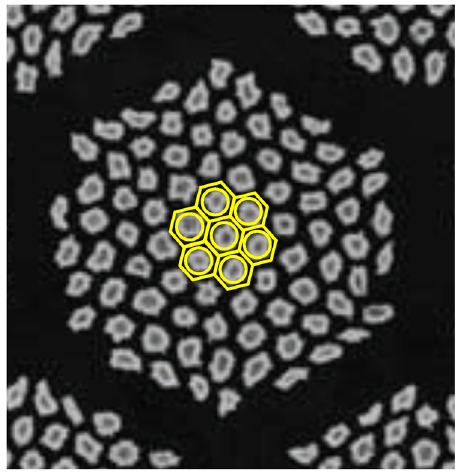
Figure 3: Microscale structure of a fi lament group and corre - sponding hexagonal unit cell representation. ( Reprinted from ref. [ 13 ] with copyright permission from Elsevier )